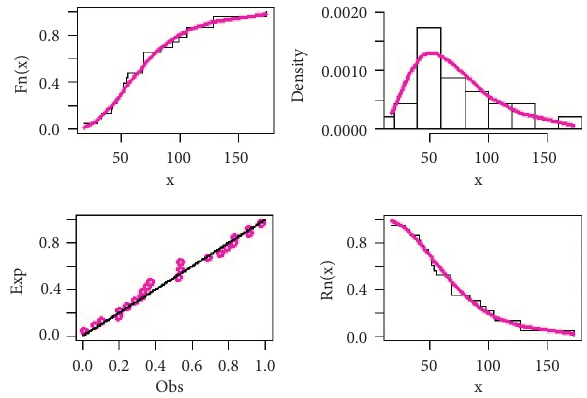
Figure 12: Plots of density, CDF, and survival of the GED for data set 1.